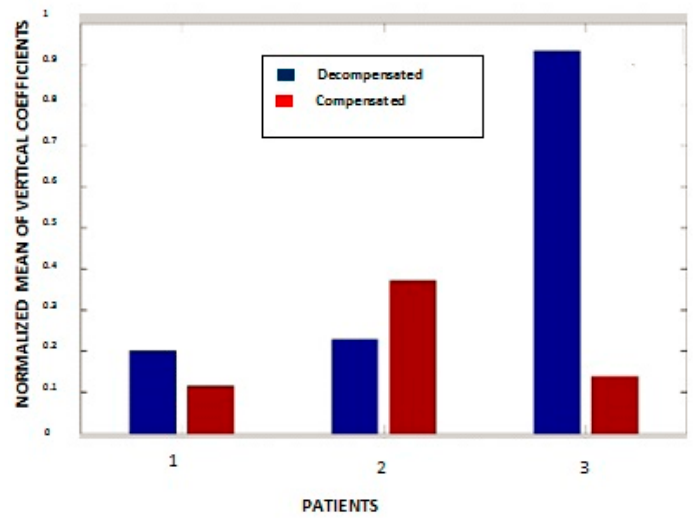
Figure 9. Comparative results of averaging many short duration heart signals (from one S1 sound to the next).